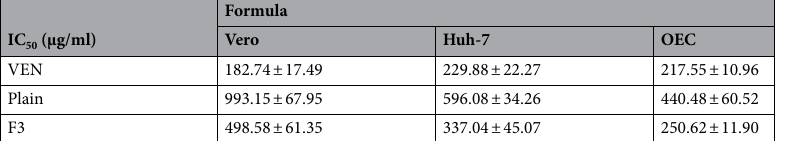
Table 4. IC 50 of VEN, plain, and combined samples in the studied cell lines after 48 h. IC 50 ; the concentration that killed 50% of cells, Vero; Green monkey kidney, Huh-7; Liver cancer, OEC; Oral epithelial cell (mean ± SD; n = 3).